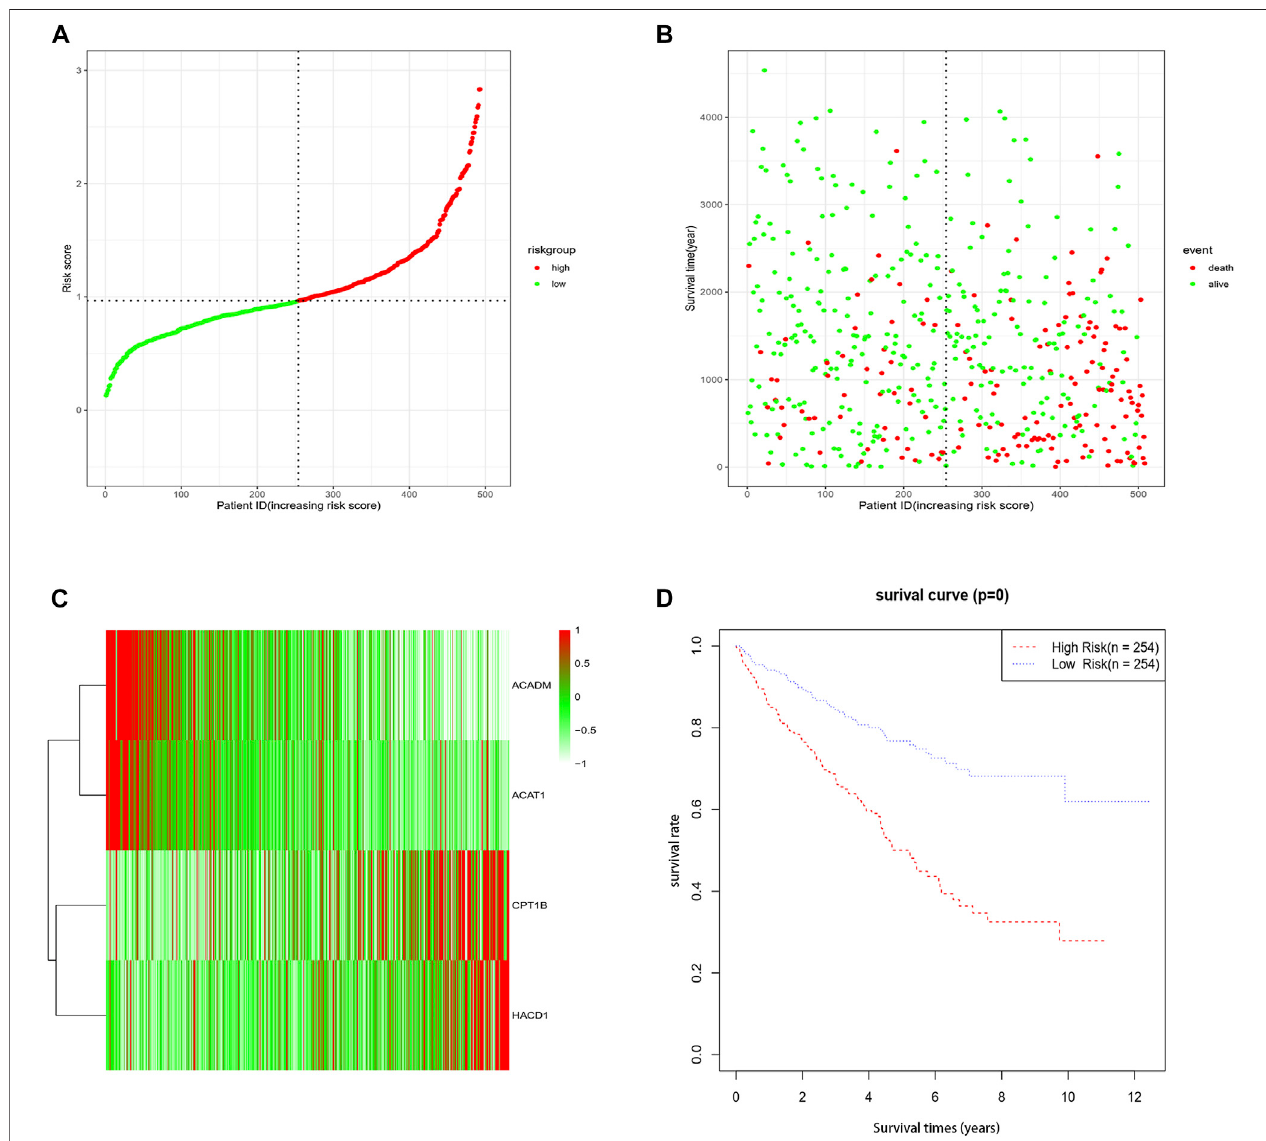
FIGURE 2 | Association between fatty acid metabolism risk signature and patient survival. (A) Distribution of each sample by risk scores. (B) Association between riskscoresandsurvivaltimeandsurvivalstatus. (C) Heatmapoftheexpressionpro fi leofthefourgenes. (D) K-Msurvivalcurveofthehigh-riskgroupandlow-riskgroup.